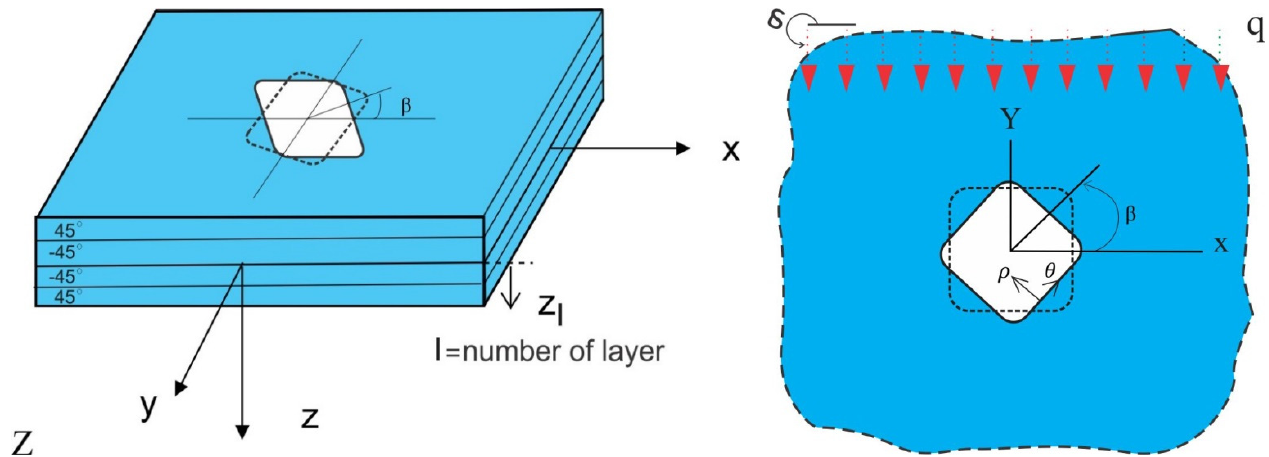
Figure 1. Symmetric composite laminated containing a rectangular hole subjected to steady heat flux [37].